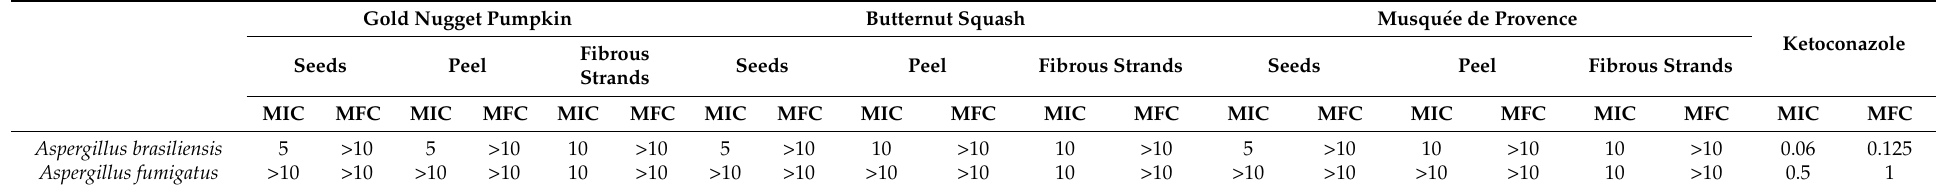
Table 9. Antifungal activity of the byproducts of three pumpkin genotypes from Algeria. Gold Nugget Pumpkin Butternut Squash Musqu é e de Provence Fibrous Peel Strands